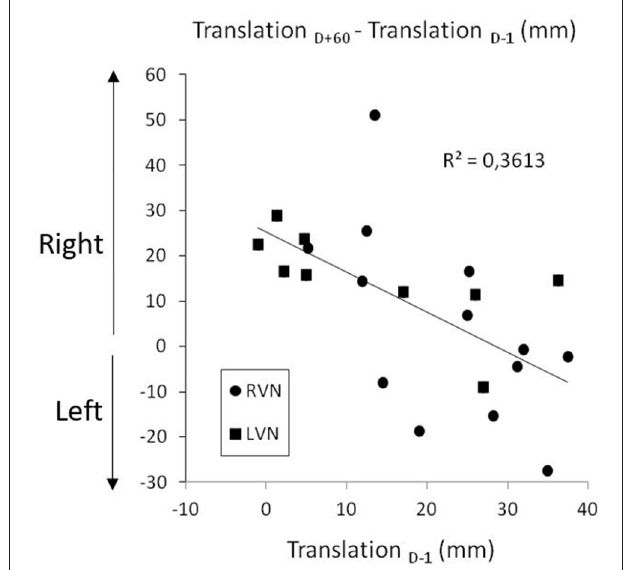
FIGURE 4 | Long-term increase of the right translation bias as a function of the initial bias in right (RVN) and left (LVN) operated patients.